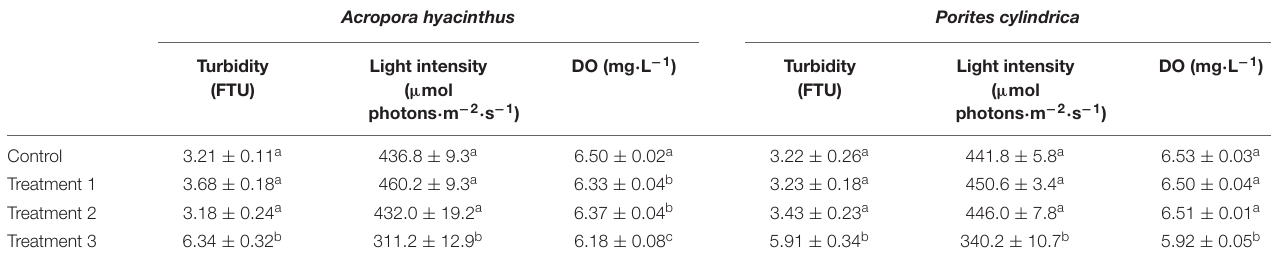
TABLE 1 | Environmental parameters for different treatments (the control, treatments 1, 2, and 3) in two